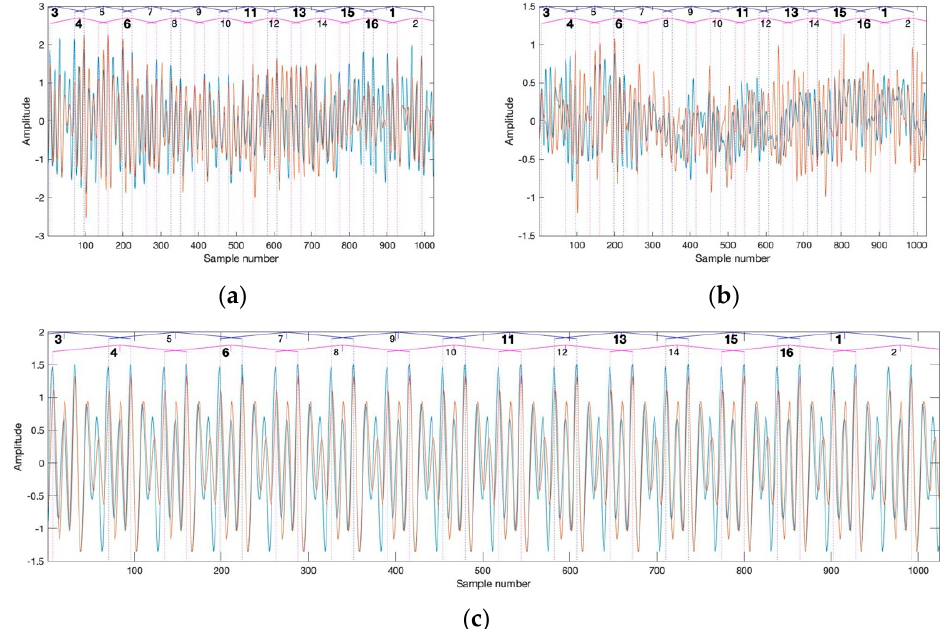
Figure 4. Gear TSA vibration signal ( a ), gear CRS vibration signal ( b ), the gear vibration meshing components ( c ), reprinted from ref. [59]. components ( c ), reprinted from ref.